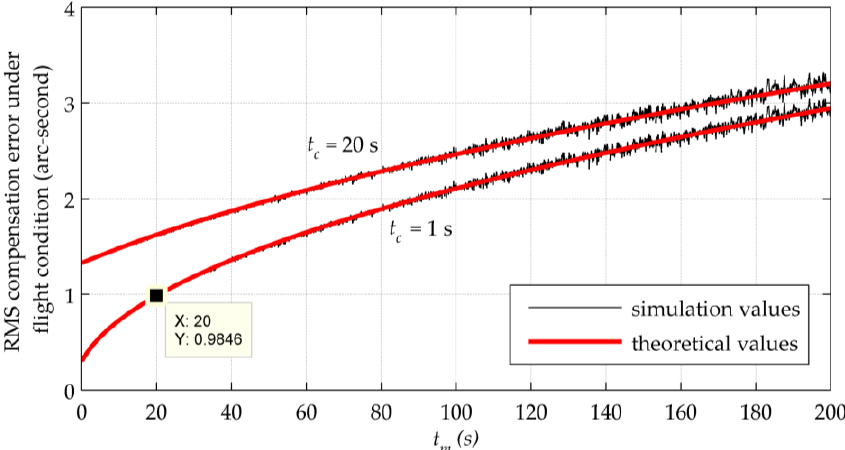
Figure 5. Simulation and theoretical values of the RMS difference between x c ( t ) and x r ( t ) under the common experimental flight condition.